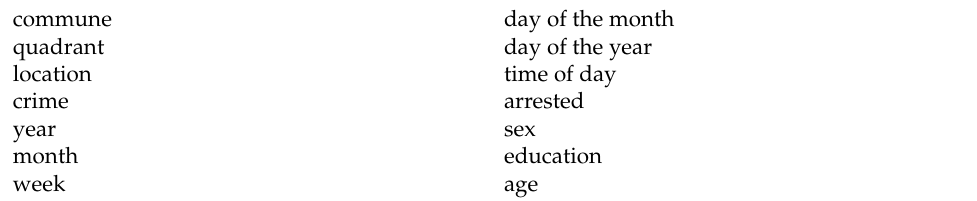
Table 2. Variables in the